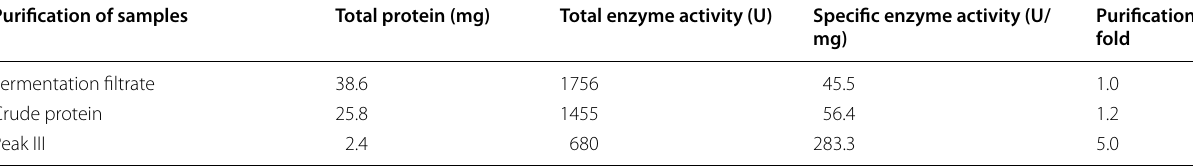
Table 6 The purification efficiency of antagonistic protein from B. pumilus HR10 Purification of samples Total protein (mg)